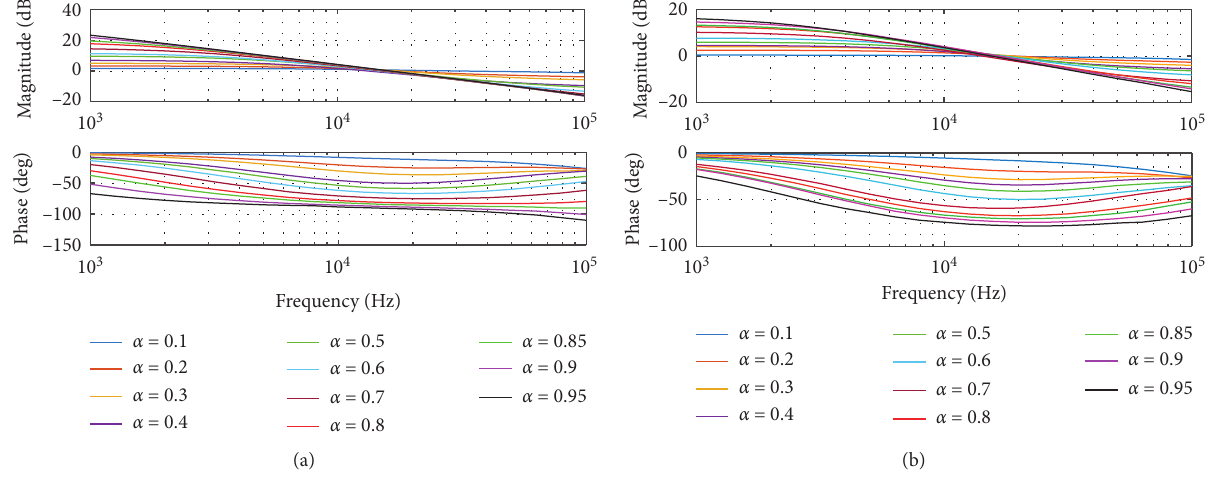
Figure 4: Experimental results of the fractional-order integrator: (a) without adjustment and (b) with adjustment. Table 1: A adjustment for each order α � ( 0 . 1 , 0 . 2 , 0 . 3 , 0 . 4 , 0 . 5 , 0 . 6 , 0 . 7 , 0 . 8 , 0 . 85 , 0 . 9 , 0 . 95 ) .